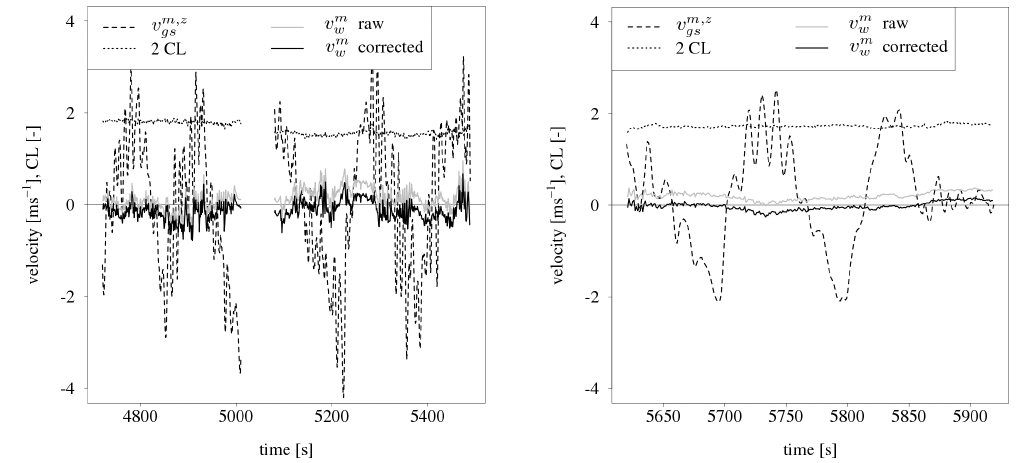
Fig. 10. Smooth oscillation flights (VW2) on 24 June 2008 (left) and 25 June 2008 (right). In addition to the variables explained in Fig. 8 the vertical aircraft velocity ( v m ,z gs ) is shown. Additional information is given in Sect. 4.1 Step G3. independence of v m from v tas , the detected BIAS depends on w α up , off in Eq. (7). Both, α up , off and α upw , slo were determined using the VW1 flight on 25 June 2008 during ambiguous cy- clonality atop and below measurement altitude (Table 3). In Fig. 9 the determination of α upw , slo depends on the change